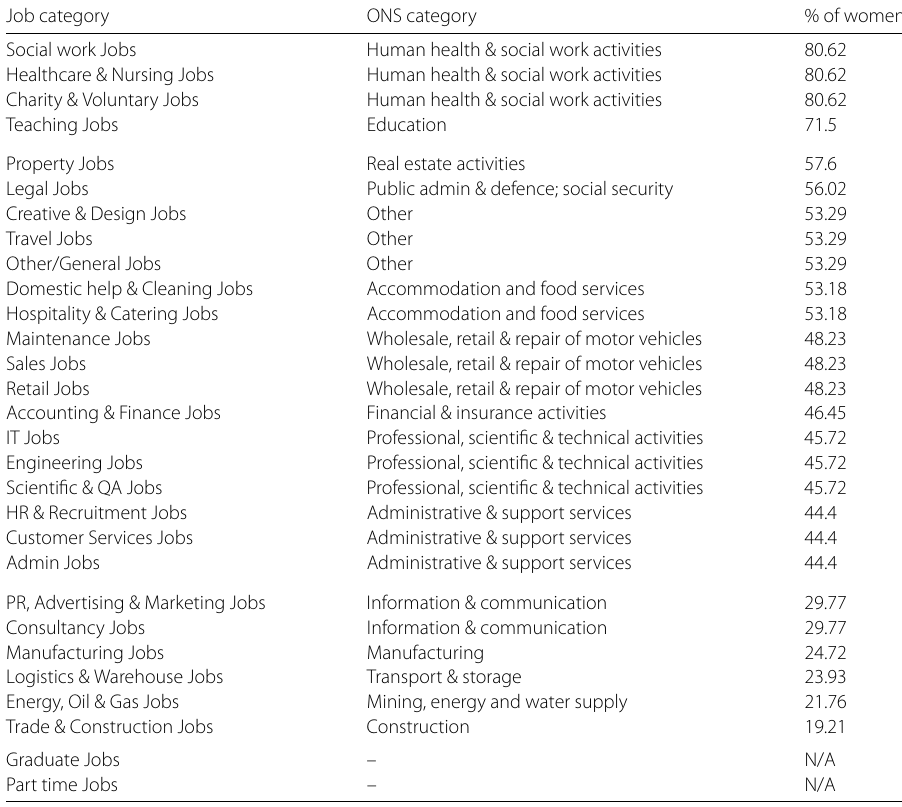
Table 3 The percentage of women in job categories Job